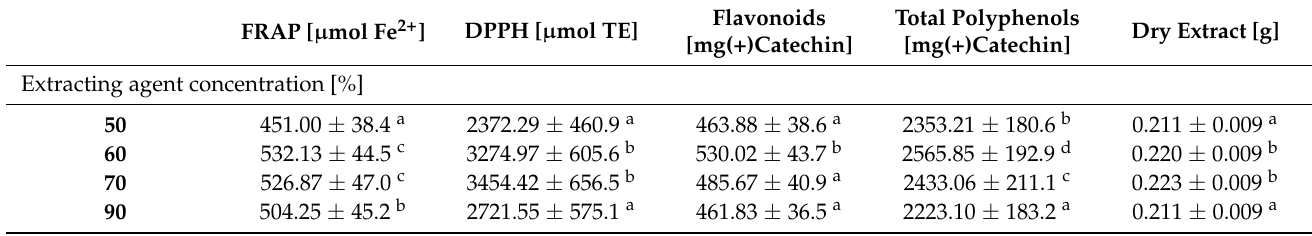
Table 4. The influence of the concentration of the solvent used on the antioxidant properties of the elderflower extracts (FRAP, DPPH), the total contents flavonoids and polyphenols, and content of the dry extract in grams (SE ± , n =